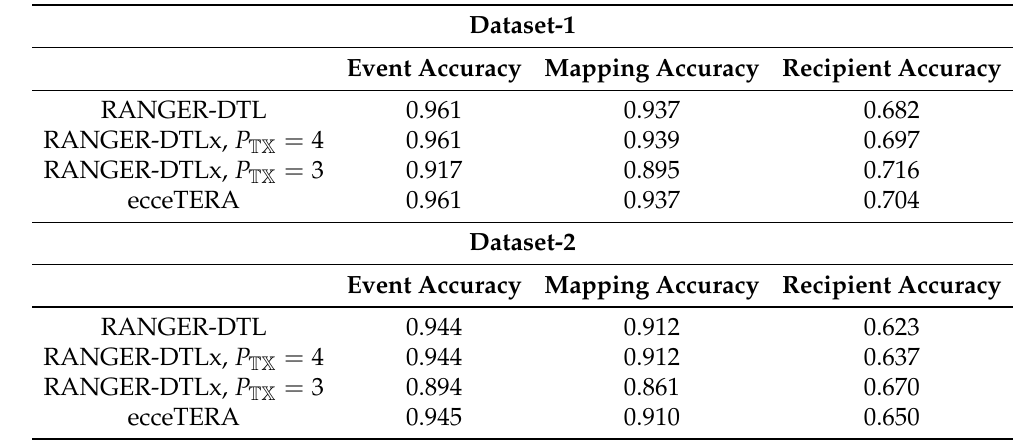
Table 2. Overall reconciliation accuracy. Average reconciliation accuracy, in terms of mapping accuracy and event assignment accuracy, is shown for each method. Event/mapping accuracy for a given input gene tree is calculated as the total number of correct events/mappings divided by the total number of internal nodes in that gene tree. The table also shows the accuracy of inferred recipients for transfer events. This recipient accuracy for each gene tree is calculated as the total number of correctly identified recipients divided by the total number of correctly identified transfers. Results are averaged across the 500 gene tree/species tree pairs in each